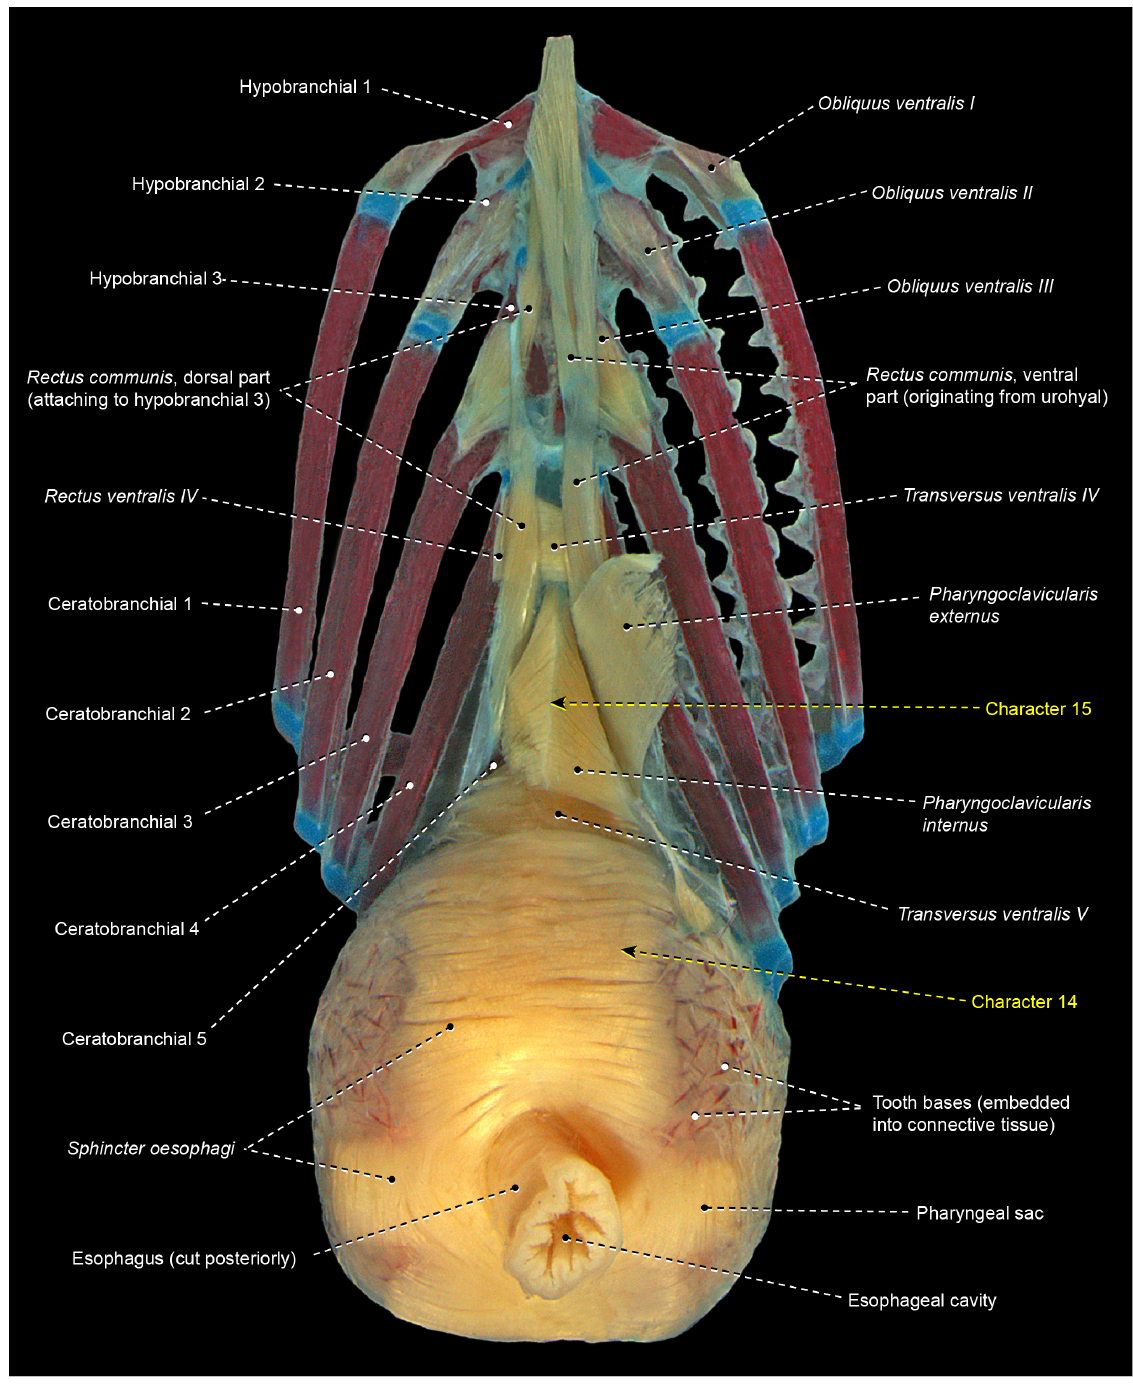
Figure 15. Branchial musculoskeletal system of Peprilustriacanthus (Stromateiformes: Stromateidae). MZUSP 112356. Ventral view; right gill rakers, ventral part of the rectus communis , and pharyngoclavicularis externus removed; right pharyngoclavicularis internus